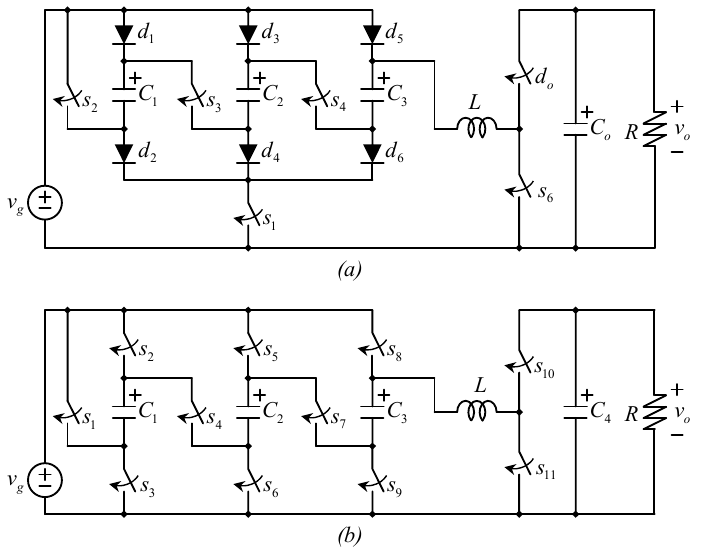
Figure 25. Transistors-based series parallel SC converters in the literature, ( a ) circuit studied in [47,48], ( b ) circuit studied in [49].